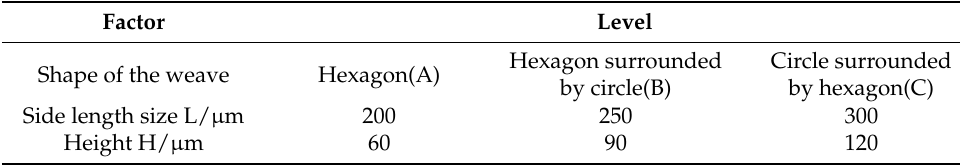
Table 9. Factor and level of the experiment.